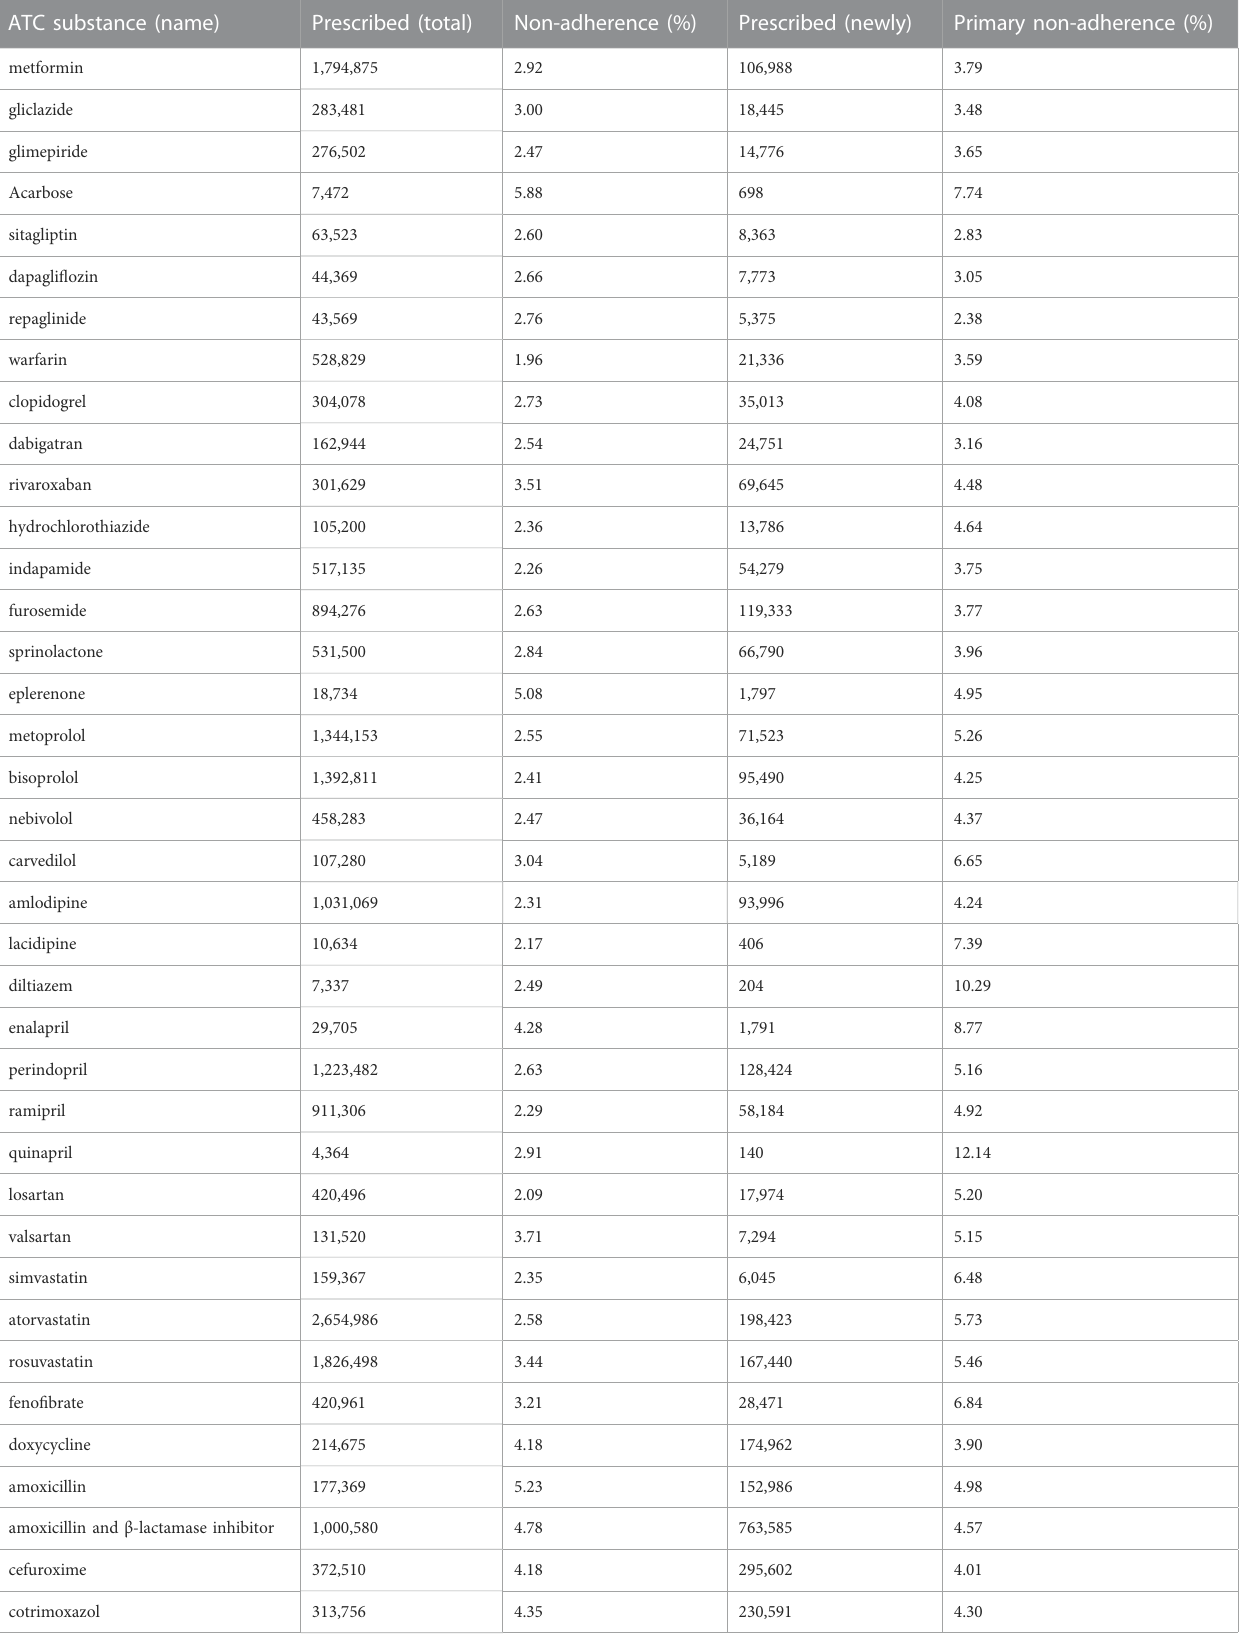
TABLE 5 Issued and collected electronic prescriptions in the selected ATC substances — non-adherence and primary